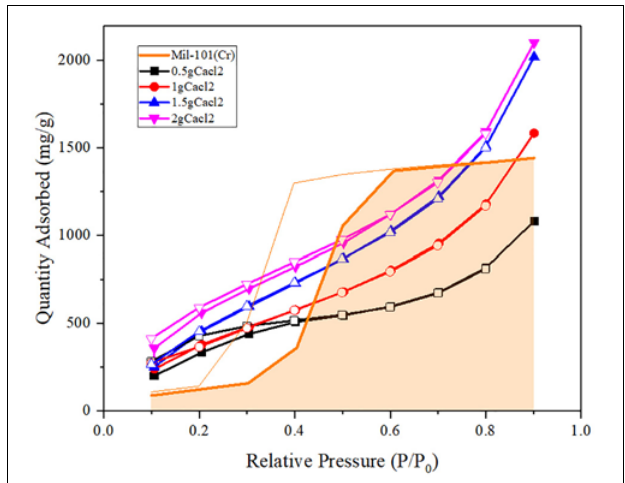
FIGURE 4 | Water adsorption isotherms of calcium chloride mil-101 (Cr) composite compared with mil-101 (Cr) composite.